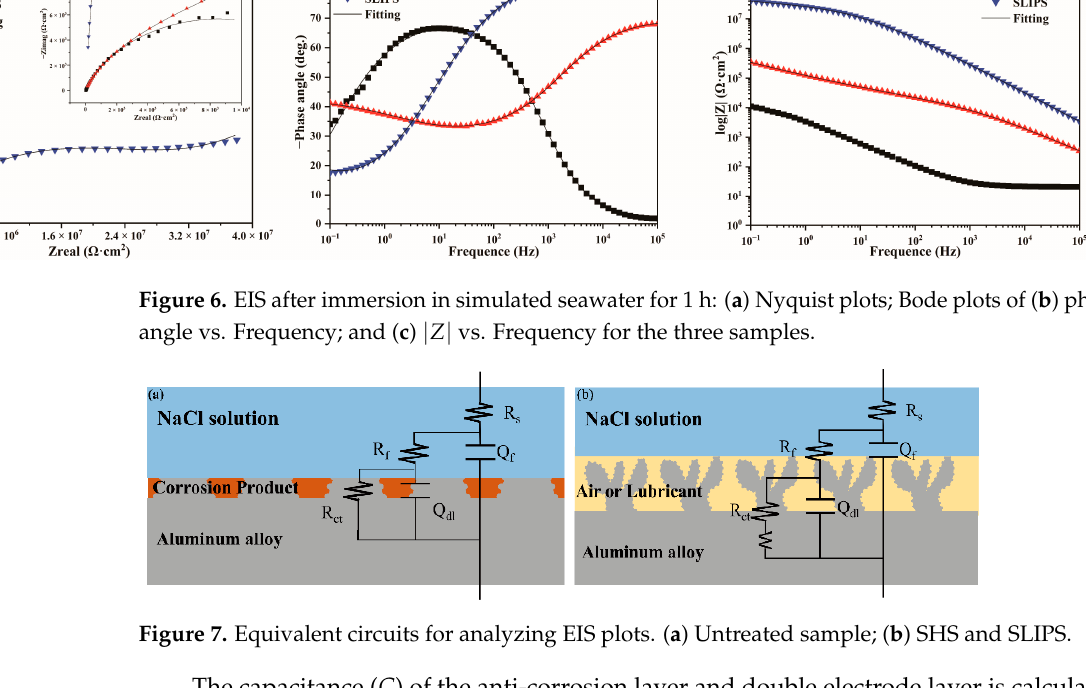
Table 2. Electrochemical parameters obtained from EIS simulation with equivalent circuit after im ‐ mersion in simulated seawater for 1 h.